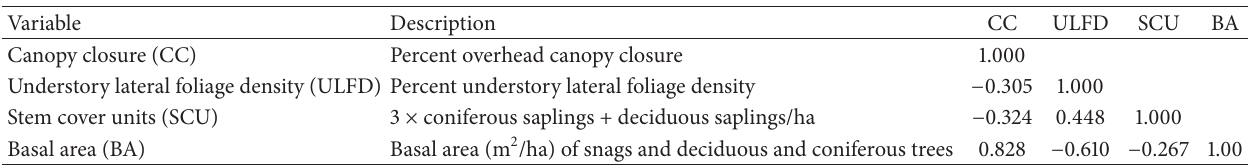
) for the a priori set of candidate models considered to examine c